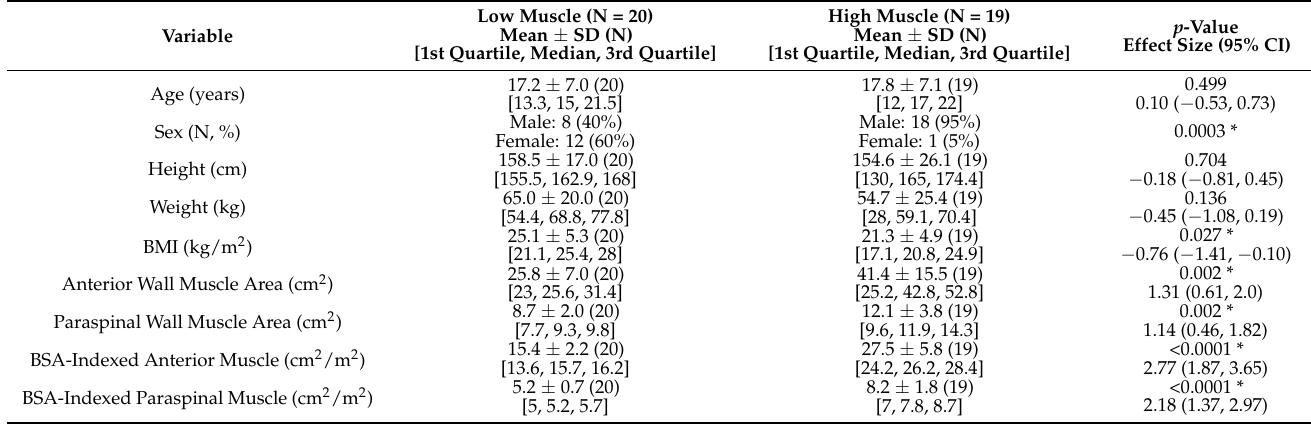
Table 5. Low and high muscle mass characteristics. Mann–Whitney U was used due to sample sizes < 30. Effect sizes were calculated by using Cohen’s d test for groups with similar sample sizes or sample sizes > 20. Hedges’ g test was used to calculate effect size for groups with largely different sample sizes or sizes <